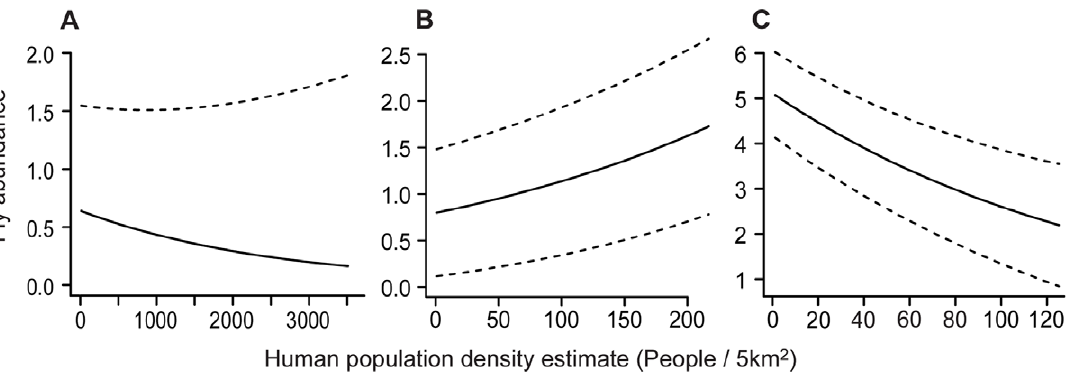
Figure 1. Predicted fly abundance. Fly abundance predicted across the range of human population estimate (HPE) in which (a) Artibeus planirostris (b) Carollia perspicillata and (c) Pteronotus parnellii occurred in the Smithsonian Venezuela Project data set. HPE was estimated as the mean number of inhabitants at a 5 km radius, as extracted from a GIS layer which specifies the number of inhabitants in , 5 km spatial resolution (see Methods for details). Dashed lines represent the standard error of the mean and are not presented below zero.